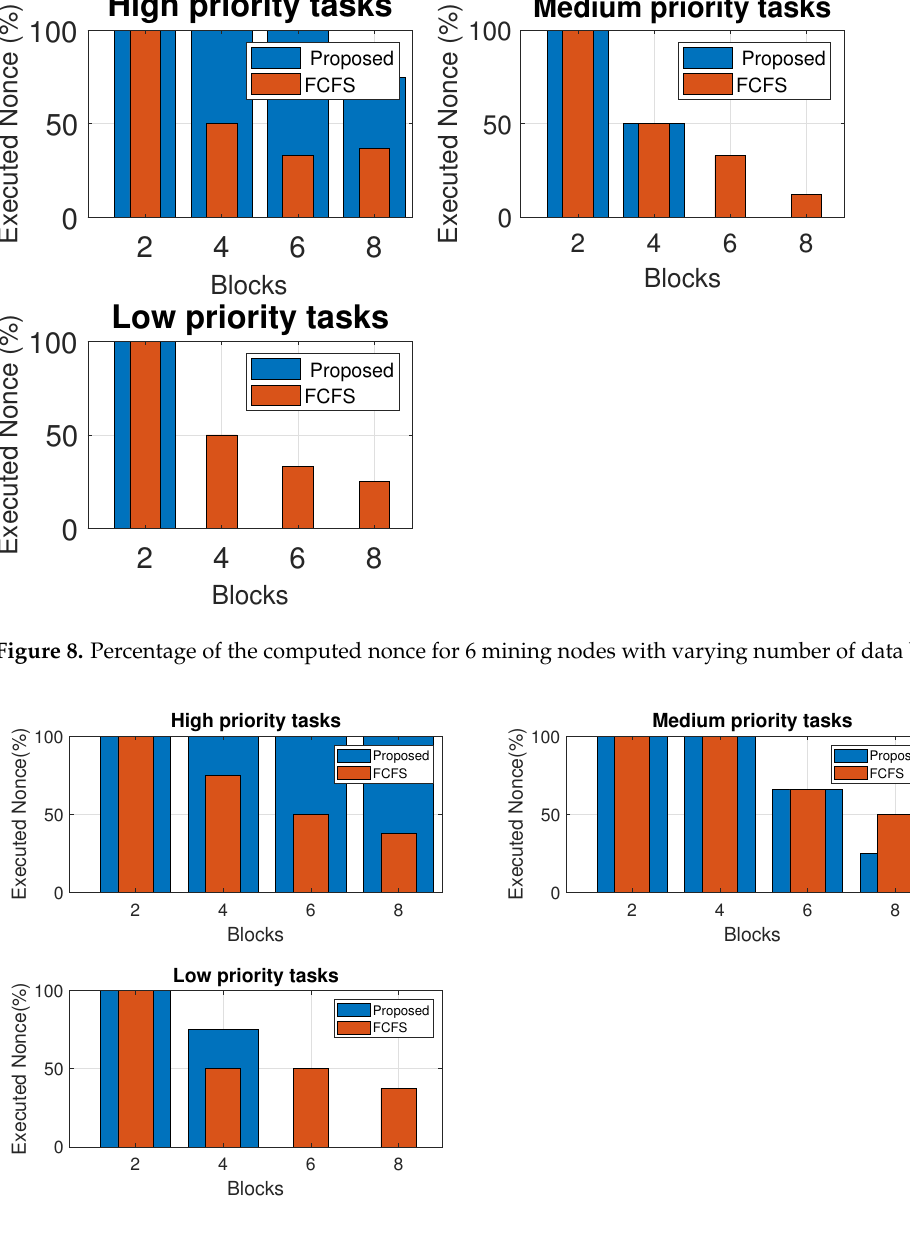
Figure 9. Percentage of the computed nonce for 10 mining nodes with varying numbers of data